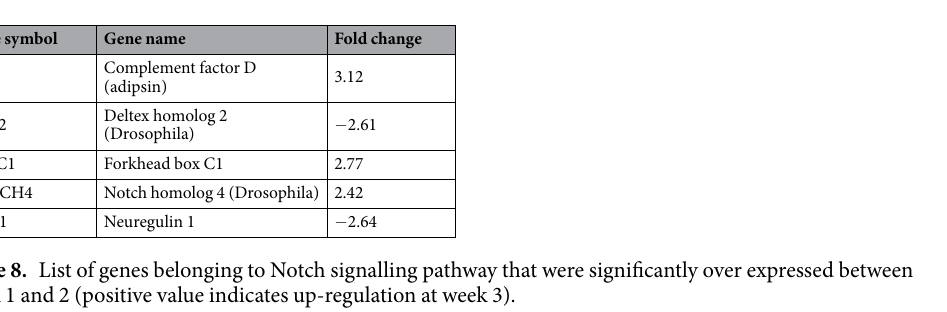
regenerating bone defect with the over-expression of large numbers of osteogenesis related mechanisms including ossification, skeletal system development and biomineral formation. Furthermore, cell differential and cell adhe- sion, genes related to bone extracellular matrix (DMP1, COL11A2, COL3A1, COL5A2), osteogenesis-related growth and differentiation factors (BMP2, TGFB3) as well as transcriptional regulators of osteoblast function (RUNX2) were all over-expressed at week-2. Significant osteogenic activity can be detected between week-1 and week-2 and this phenomenon is coordinated with the histological results that the periosteum of defects site at week-2 was thicker and the cells of cambium layer at week-2 were much more active. These findings are also in accordance with microarray studies of rat bone fracture healing and GBR of cranial defects 8–10,20 .